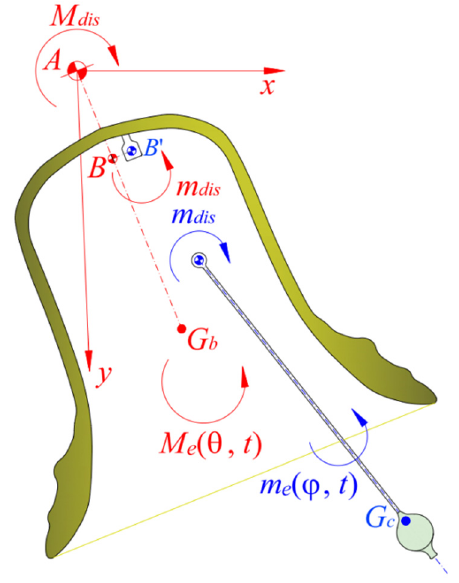
Figure 2. Generalized moments acting on bell and clapper.